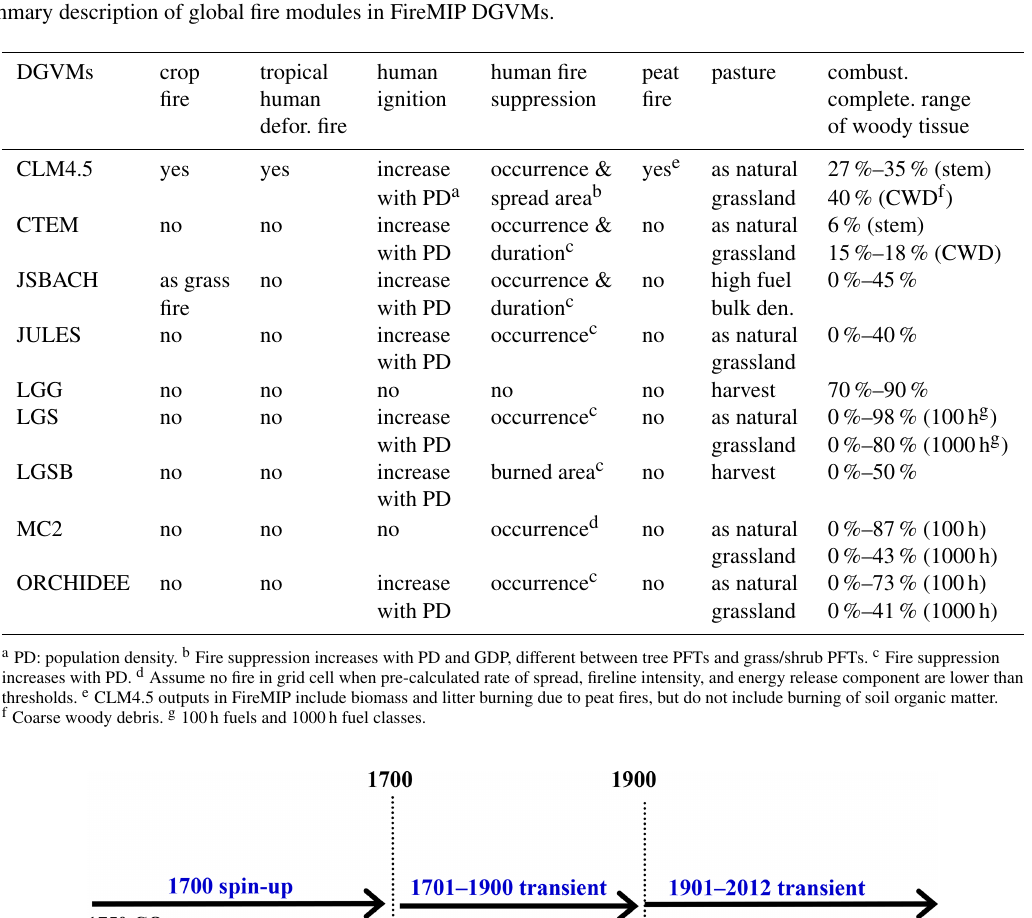
Table 2. Summary description of global fire modules in FireMIP DGVMs.